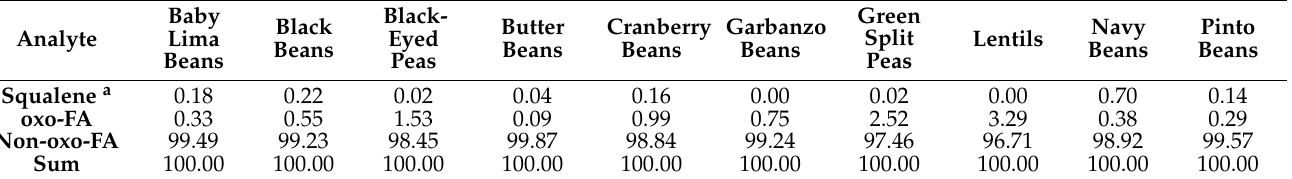
from 0.09% in butter beans to 3.3% in lentils. Table 2. Mole percentages of squalene, total oxo-fatty acids, and total non-oxo fatty acids in ten pulse samples as determined from GC-FID peak